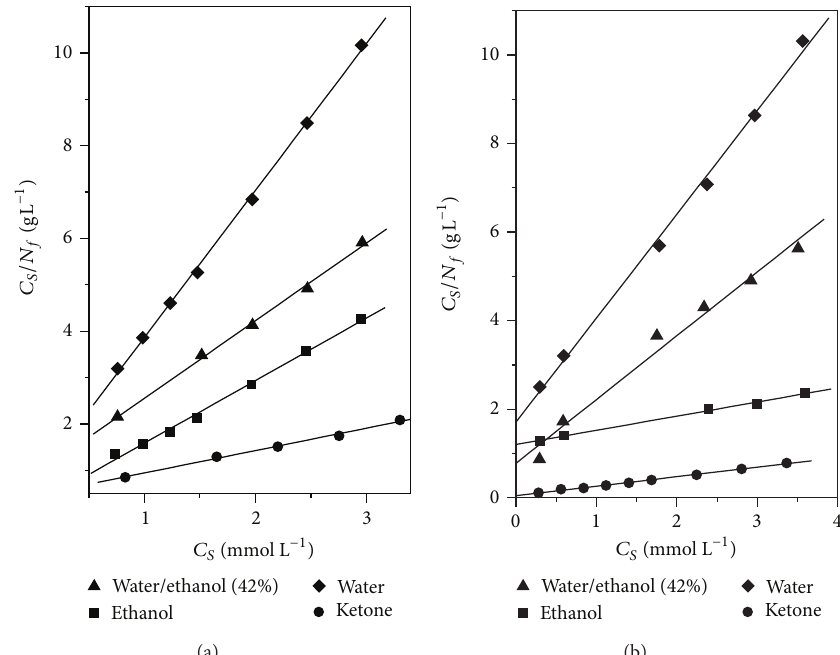
Figure 7: Adsorption isotherms of copper (a) and nickel (b) ions in several solvents solutions on SGAPC as plot of 𝐶/𝑁 𝑓 against 𝐶 𝑆 at 25 ∘ C.